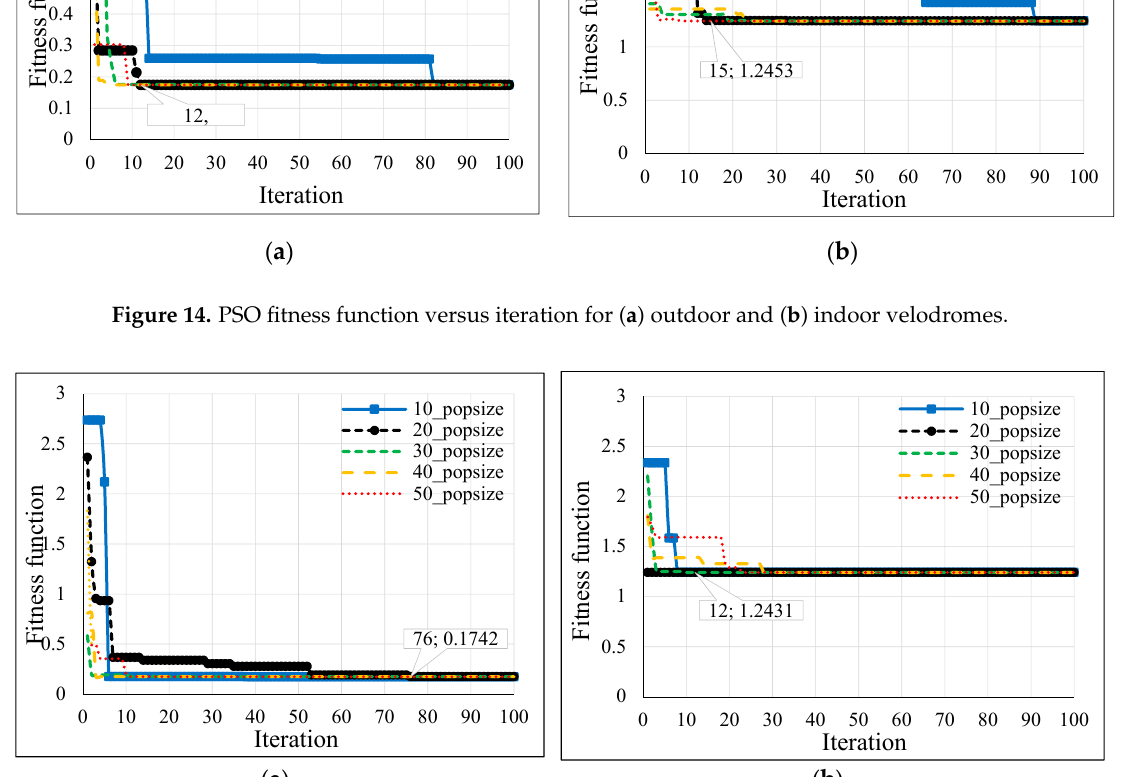
Figure 15. BSA fitness function versus iteration for ( a ) outdoor and ( b ) indoor velodromes.